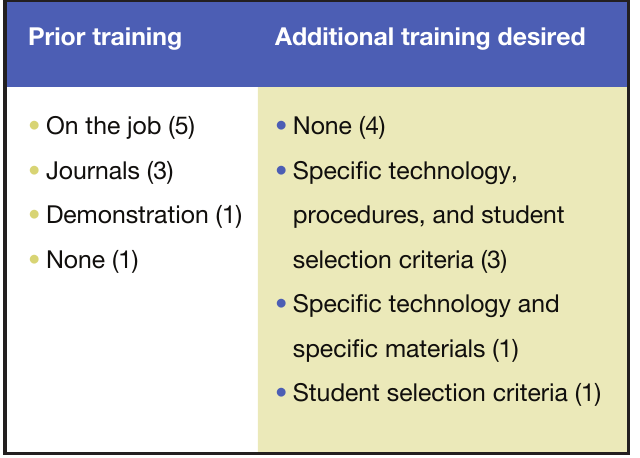
Table 1 Prior Training Received and Additional Training